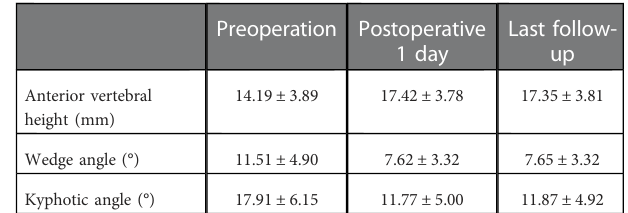
TABLE 3 Radiographic measurements of anterior vertebral height, wedge angle, and kyphotic angle ( n =41).